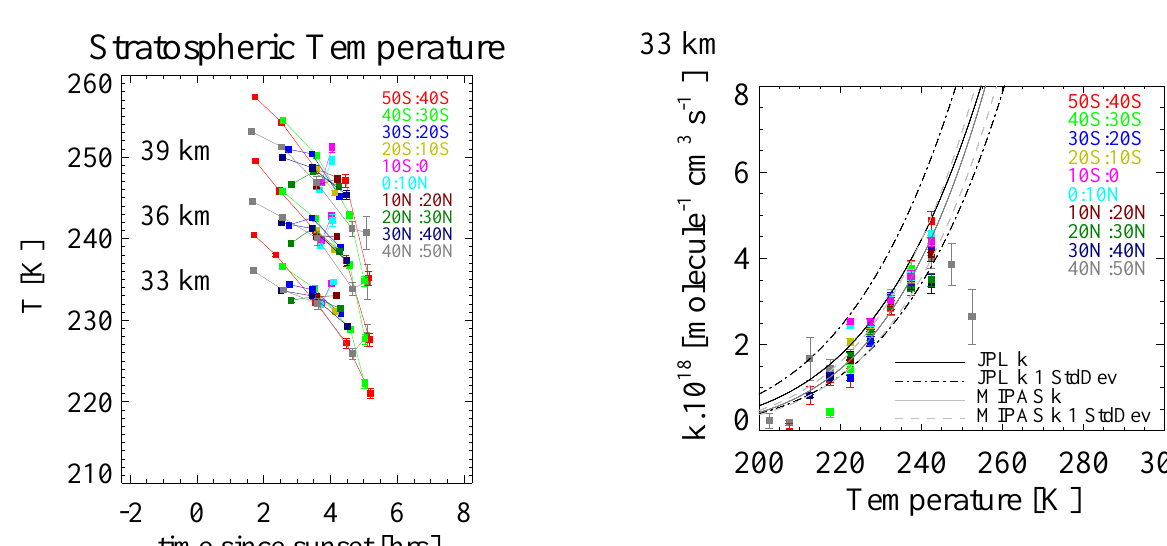
Fig. 7. Temperature dependence of reaction rate at 33km using (cid:16) 2 1 [ N (cid:17) Fig. 6. Temperature dependence of reaction rate determined at tangent altitudes of 33 km + 1 2 O 5 ] k obs = 1 ln in Eq. (3) assuming possible non- (cid:16) (cid:17) Fig. 6. Stratospheric temperature observed by MIPAS at 33, 36 [ NO 2 ] 2 [ O 3 ] t 2∆[ N 2 O 5 ] ln +1 using k obs = 1 in Eq. (3) assuming possible non-negligible [ N 2 O 5 ] at sunset Fig. 9. Stratospheric temperature observed by MIPAS at 33, 36 and 39 km binned by hour 2[ O 3 ] t [ NO 2 ] negligible [N 2 O 5 ] at sunset binned in 5K temperature increments and 39km binned by hour since sunset in 10 ◦ latitude bands where since sunset in 10 ◦ latitude bands where 50–40 ◦ S is shown in red, 40–30 ◦ S in light green, 30– binned in 5 K temperature increments in 10 ◦ latitude bands where 50–40 ◦ S is shown in red, in 10 ◦ latitude bands where 50–40 ◦ S is shown in red, 40–30 ◦ S in 50–40 ◦ S is shown in red, 40–30 ◦ S in light green, 30–20 ◦ S in dark 20 ◦ S in dark blue, 20–10 ◦ S in yellow, 10–0 ◦ S in pink, 0–10 ◦ N in pale blue, 10–20 ◦ N in maroon, 40–30 ◦ S in light green, 30–20 ◦ S in dark blue, 20–10 ◦ S in yellow, 10–0 ◦ S in pink, 0–10 ◦ N in light green, 30–20 ◦ S in dark blue, 20–10 ◦ S in yellow, 10–0 ◦ S in blue, 20–10 ◦ S in yellow, 10–0 ◦ S in pink, 0–10 ◦ N in light blue, 20–30 ◦ N in dark green, 30–40 ◦ N in navy blue, and 40–50 ◦ N in grey. Error bars indicate error pale blue, 10–20 ◦ N in maroon, 20–30 ◦ N in dark green, 30–40 ◦ N in navy blue, and 40–50 ◦ N pink, 0–10 ◦ N in light blue, 10–20 ◦ N in maroon, 20–30 ◦ N in dark 10–20 ◦ N in maroon, 20–30 ◦ N in dark green, 30–40 ◦ N in navy in mean. in grey. The solid grey line shows the best fit to this data and the dashed grey line shows the green, 30–40 ◦ N in navy blue, and 40–50 ◦ N in grey. The solid grey blue, and 40–50 ◦ N in grey. Error bars indicate error in mean. estimated 1 σ error of the fit. This estimate is compared against the temperature dependence line shows the best fit to this data and the dashed grey line shows the (cid:1) in Eq. (1) which is shown as a computed using the Arrhenius expression k ( T ) = A exp (cid:0) − E estimated 1 σ error of the fit. This estimate is compared against the RT 47 solid black line with the estimated 1 σ error indicated as a dot-dashed black line. temperature dependence computed using the Arrhenius expression (cid:16) − E (cid:17) k(T ) = A exp in Eq. (1) which is shown as a solid black line R T